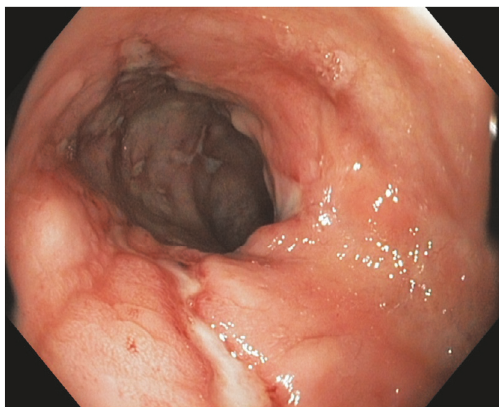
Figure 2: Endoscopic image of the caecal region shows deep, large, and oval ulcerations.